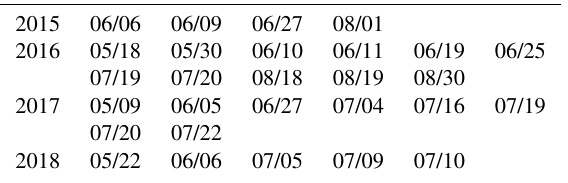
Table 1. Dates of simulations included in the analysis (month/day).